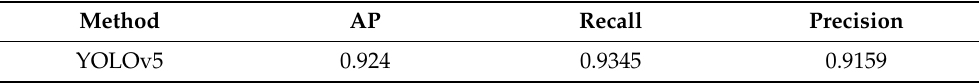
Table 2. Indicators corresponding to our